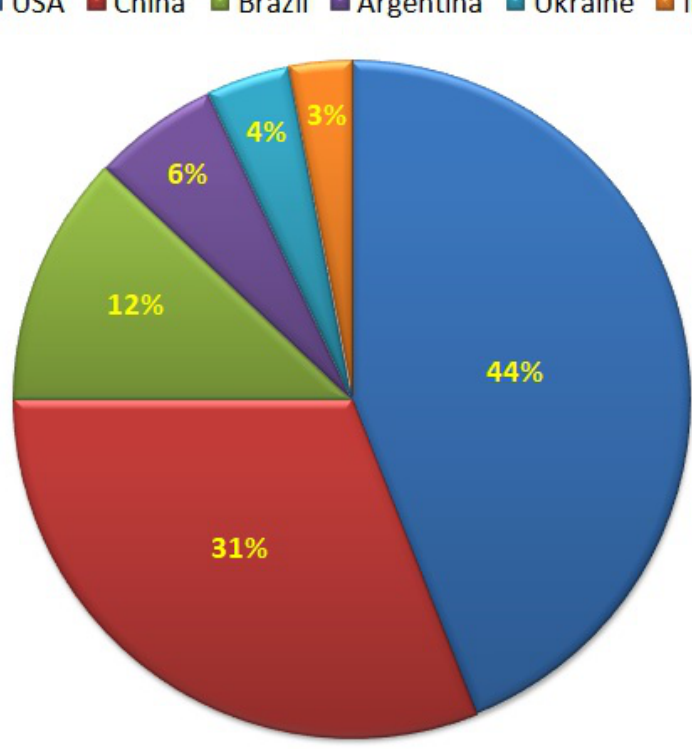
Figure 1. Corn production worldwide.